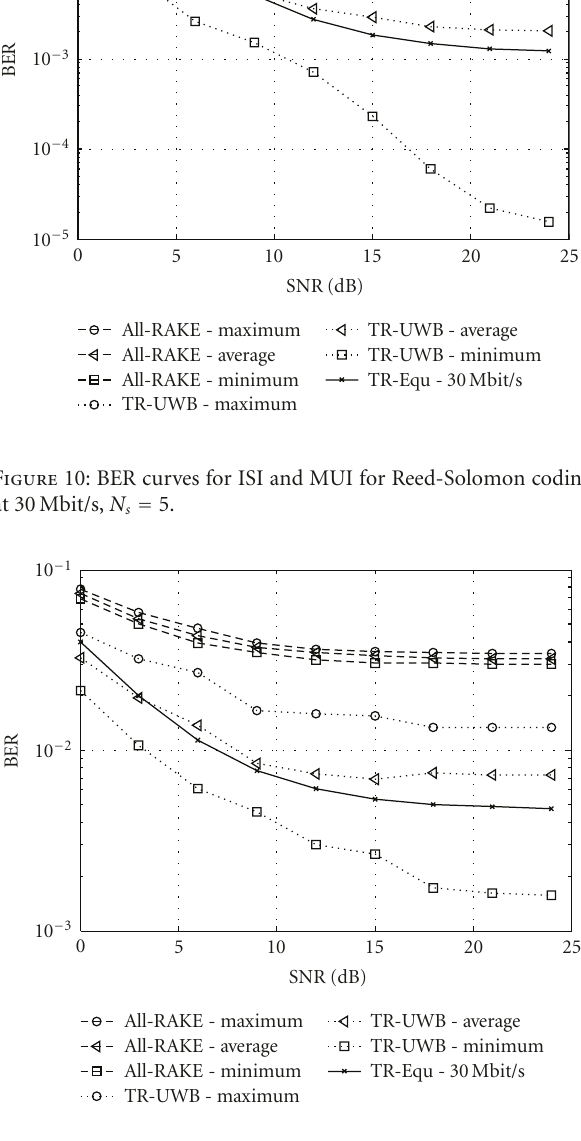
Figure 11: BER curves for ISI and MUI for Reed-Solomon coding at 30Mbit/s, N s =